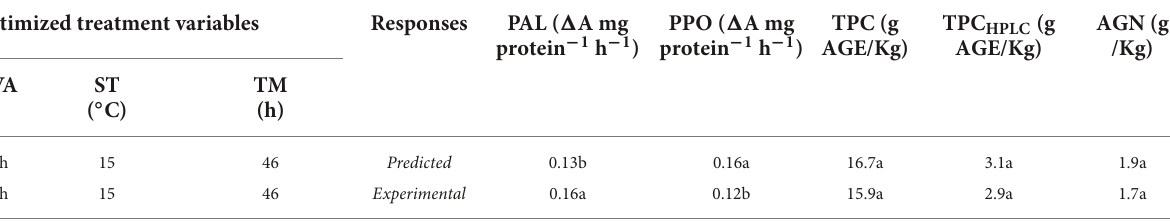
TABLE 2 Optimal biofortification treatment of strawberry by-products (RF) and their experimental and predicted response values.